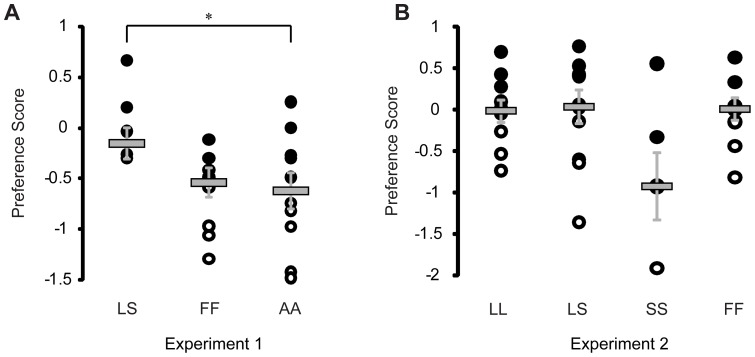
Female preference behavior.Behavioral preference scores for each individual in (a) Experiment 1 (egr-1 quantification) and (b) Experiment 2 (neuroserpin quantification) by treatment context. Gray horizontal line is the median with standard error. Black and white circles represent high (> median) and low (< median) preference score females, respectively. *, p<0.01.